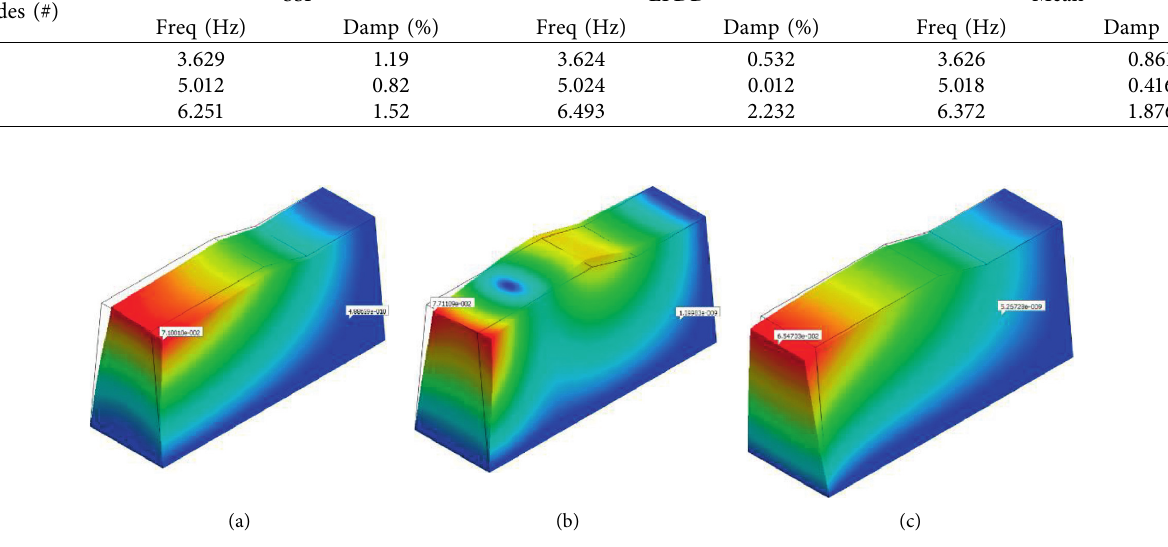
Figure 7: Numerical frequencies and vibration modes. (a) First-order transverse bending, f torsion, f 2FEM � 5.417Hz, and (c) third-order vertical bending, f 3FEM �